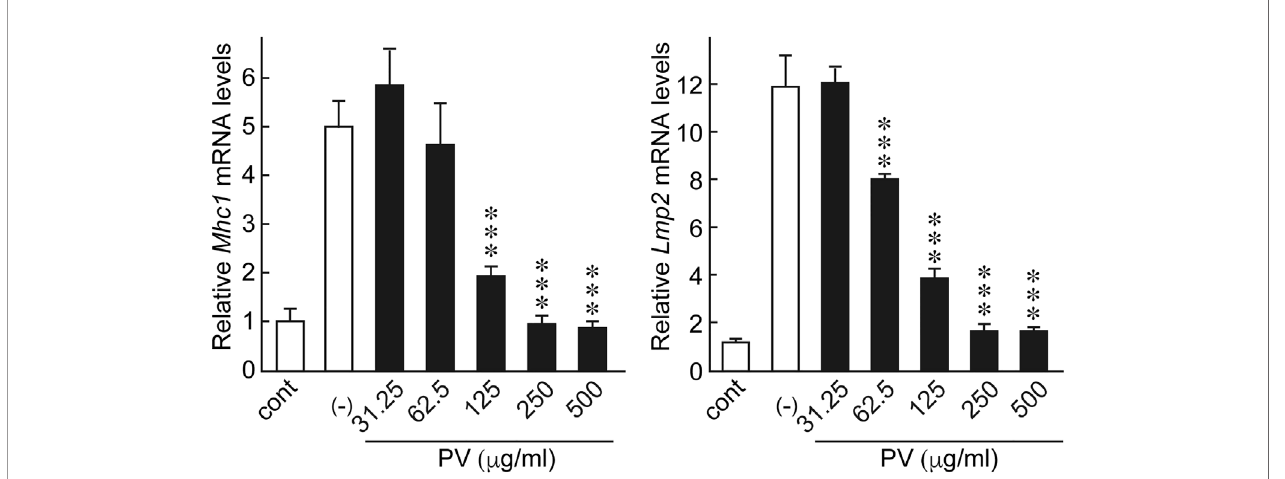
FIGURE 4 | PV inhibited genes involved in antigen presentation pathways induced by dsRNA. FRTL-5 cells were pretreated with PV at increasing concentrations (0, 31.25, 62.5, 125, 250, 500 m g/mL) for 24 h. Cells were then stimulated with 1 m g of dsRNA for 24 h in the presence of PV. Total RNA was puri fi ed from the cells and subjected to real-time PCR analysis to determine the relative mRNA expression levels of Mhc1 and Lmp2. mRNA levels were normalized against Gapdh levels and expressed as fold-change relative to the control. Data are presented as mean ± SD (n = 3) relative to the mRNA levels of non-treated control levels. *** p < 0.001, compared to PV ( − )